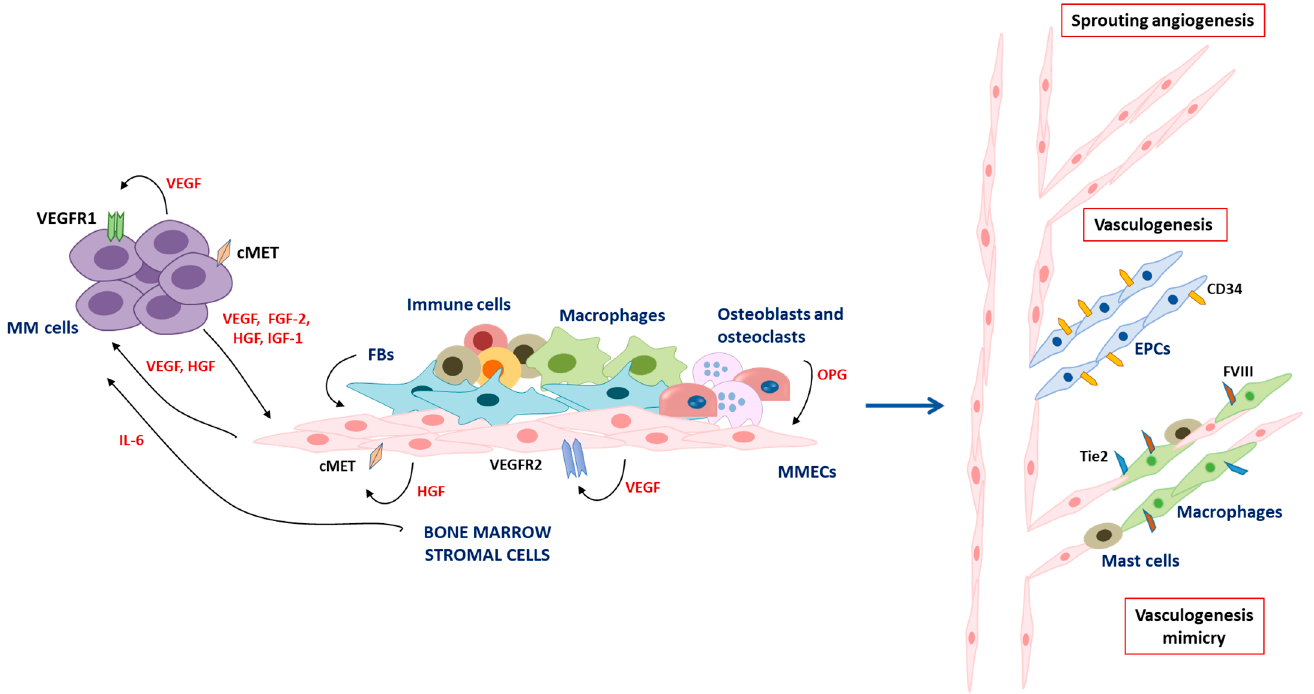
Figure 1. Graphical representation of BM angiogenesis and vasculogenesis in MM patients. MM cells release angiogenic cytokines (i.e., VEGF, FGF-2, HGF, IGF-1) that activate the BM niche. In turn, activated MMECs strongly express angiogenic receptors and secrete high levels of VEGF and HGF that act in an autocrine and paracrine manner. BMSCs contribute to this process by releasing angiogenic cytokines and IL-6, further sustaining the “angiogenic switch” and MM pathogenesis. This pro-angiogenic milieu leads to the formation of new blood vessels via: (i) sprouting angiogenesis; (ii) vasculogenesis through the recruitment of CD34 + endothelial progenitor cells (EPCs); and (iii) vasculogenesis mimicry through the recruitment of macrophages and mast cells.